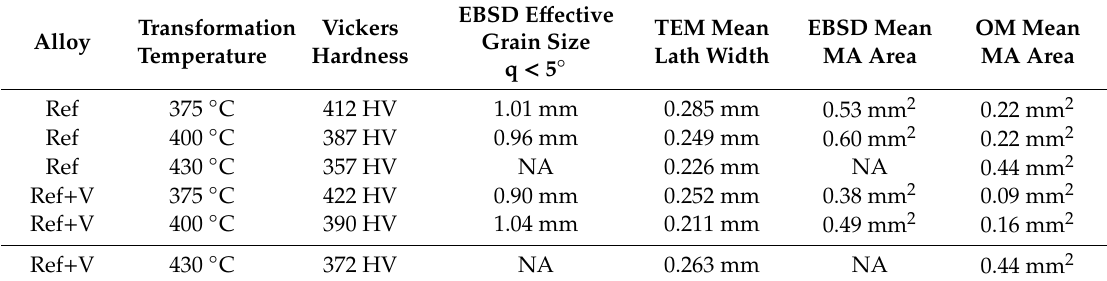
Table 4. Microstructure parameters from EBSD, TEM and OM data.